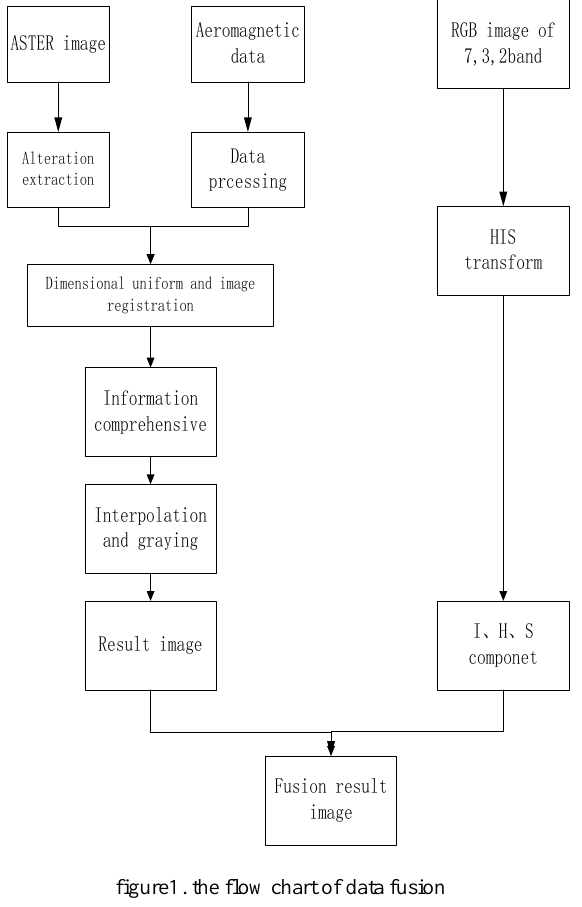
figure1. the flow chart of data fusion spectral